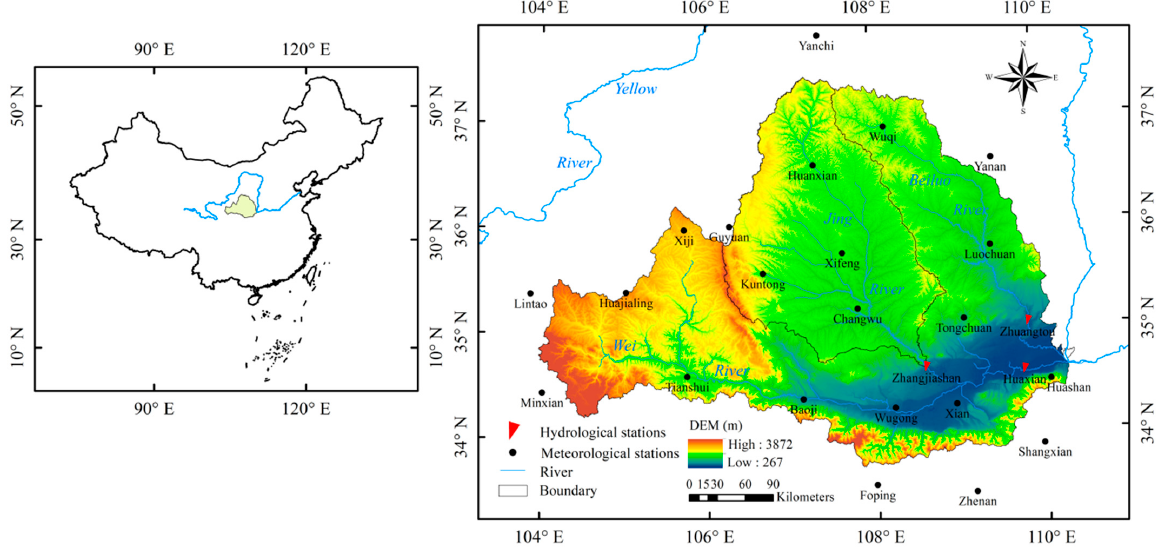
Figure 1. Location of the Weihe River Basin. Table 1. Information for the National Meteorological Observatory Stations used in this study. Sub